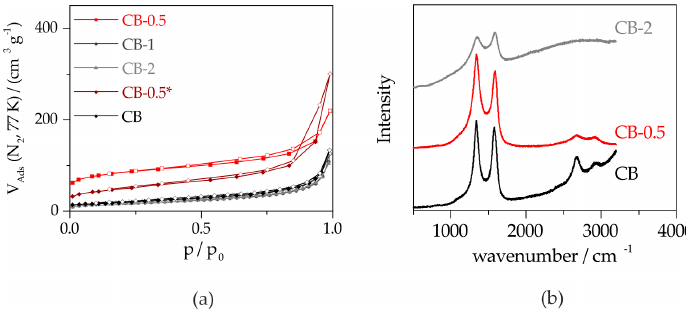
Figure 2. ( a ) Nitrogen physisorption isotherms of the milled carbon black (CB) under different conditions and ( b ) Raman spectra normalized to the intensity of the vibration at 1560 cm − 1 . Table 1. Porosity, composition data, and zeta potential of the samples.